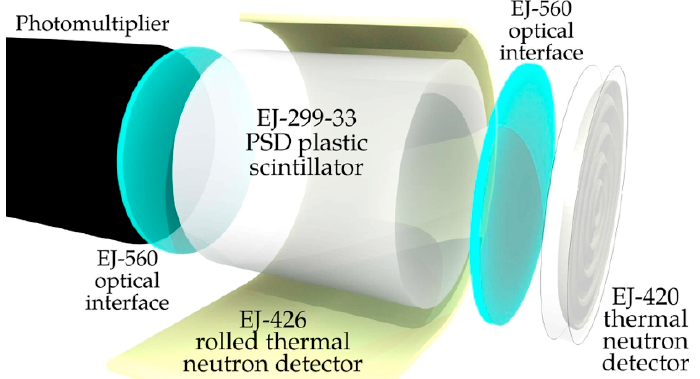
Figure 1. Assembly of the detector, Finapp, to employ in cosmic-ray neutron sensing (CRNS) technique. Abbreviation: PSD, pulse shape discrimination.